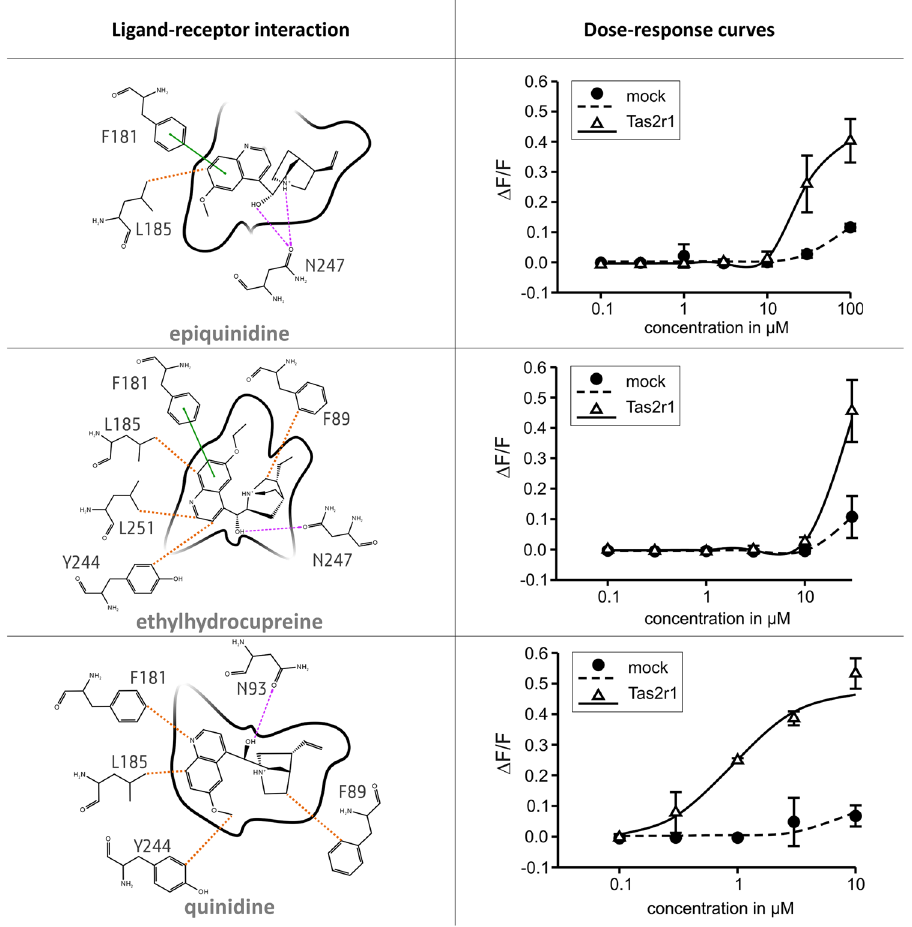
Figure 5. Newly discovered ggTas2r1 agonists, their predicted binding modes and functional data. In the 2D ligand-receptor interaction diagram, H-bond interactions are shown as magenta dashed arrows, salt bridges as blue-red lines, π−π interactions as green lines, cation −π interactions as red lines and hydrophobic interactions are represented as the distances between the closest heavy atoms of the ligand and the residue in orange dotted lines. Dose-response relations for the specified compounds in cells expressing native ggTas2r1: the y-axis shows the relative fluorescence changes ( Δ F/F), and the x-axis the ligand concentration in μ